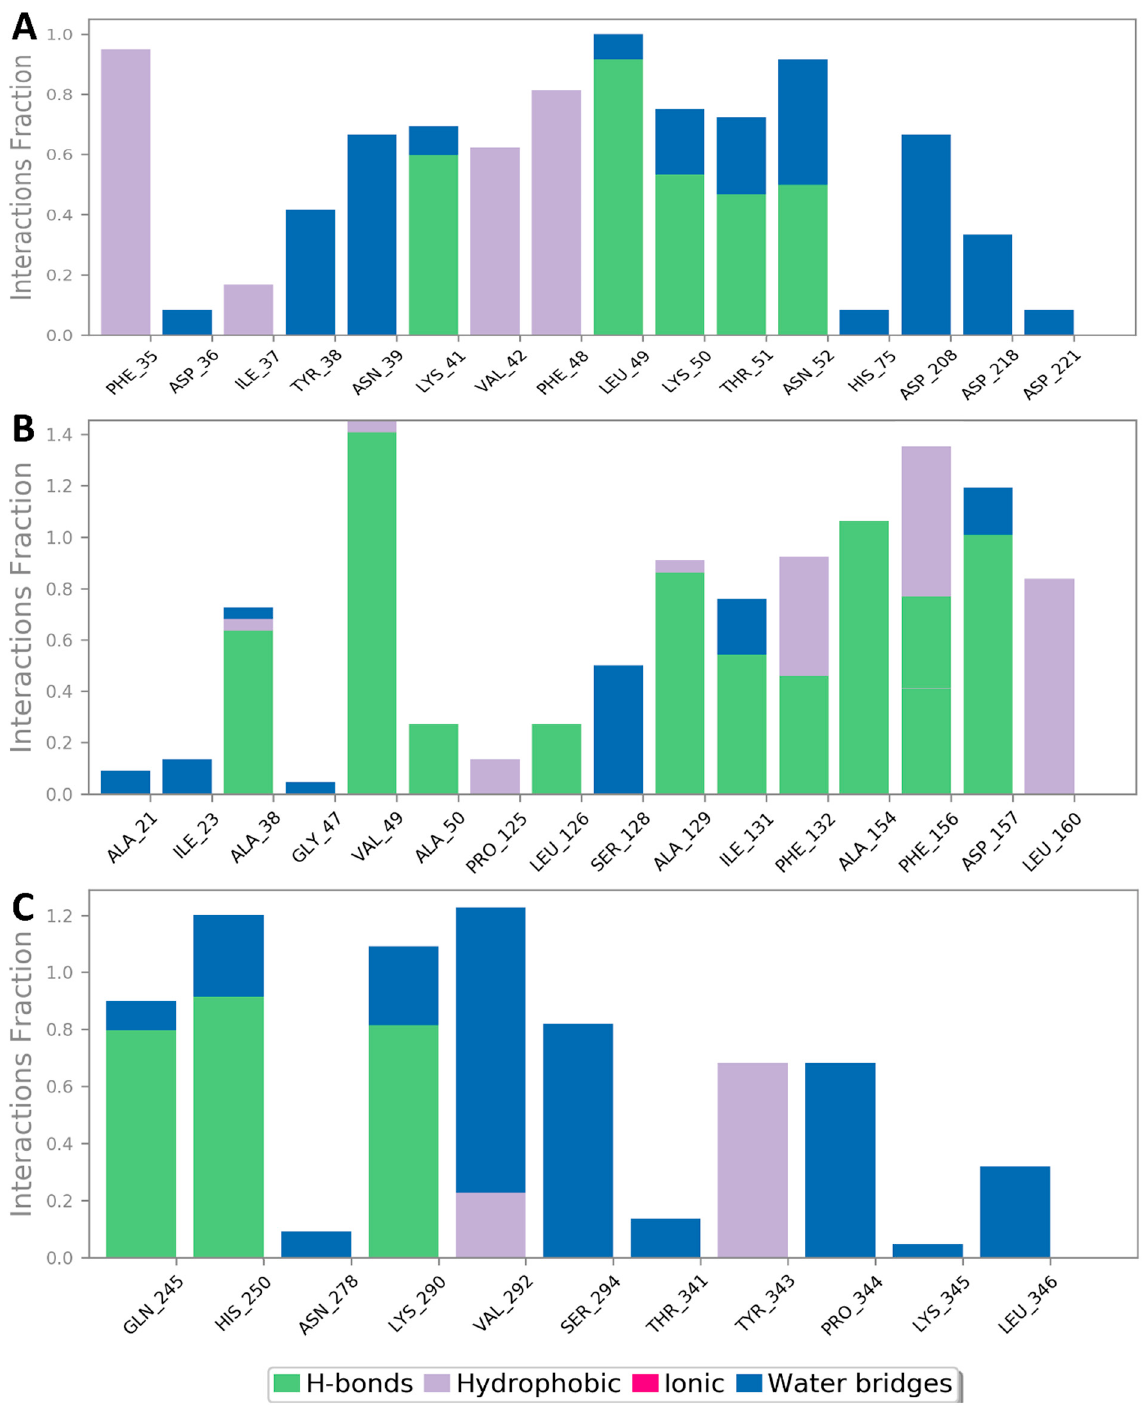
Figure 9. Protein-cnicin contacts inside the viral proteins’ binding sites during 150 ns of MDS: nsp12, nsp3, and nsp15 ( A , B , and C , respectively).